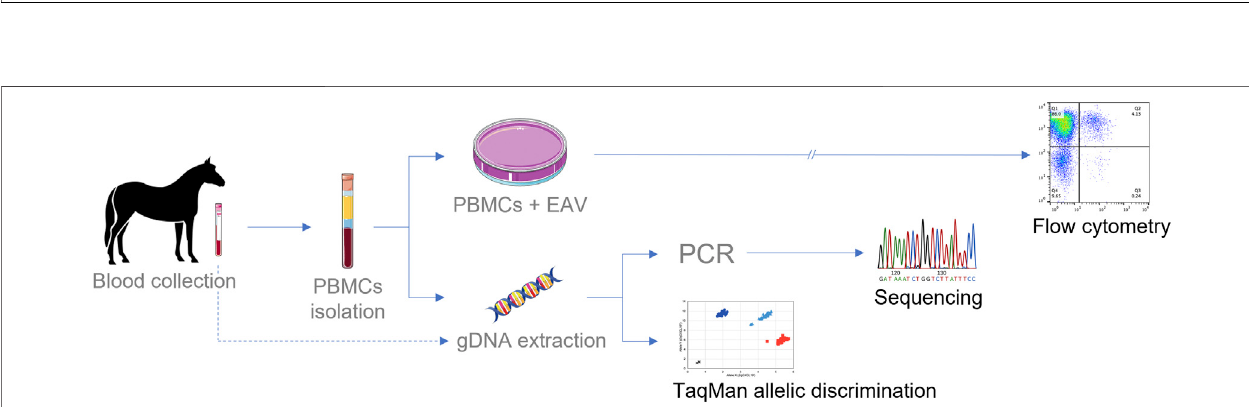
FIGURE5| SchematicdiagramfortestingEAVsusceptibilityphenotypeinCD3 + Tlymphocytesandgenotypi fi cationof CXCL16 .CulturingPBMCsinthepresence of EAV followed by fl ow cytometric analysis is the most extended method for phenotype determination ( > 36 h). Sanger sequencing of the CXCL16 gene requires an averageoftwotothreeworkingdaysforcompleteanalysis.TheTaqMan ® allelicdiscriminationqPCRassayisthetechniquethatprovidesthefastestresults,withresults in less than 24 h gDNA can be extracted from PBMCs or directly from whole